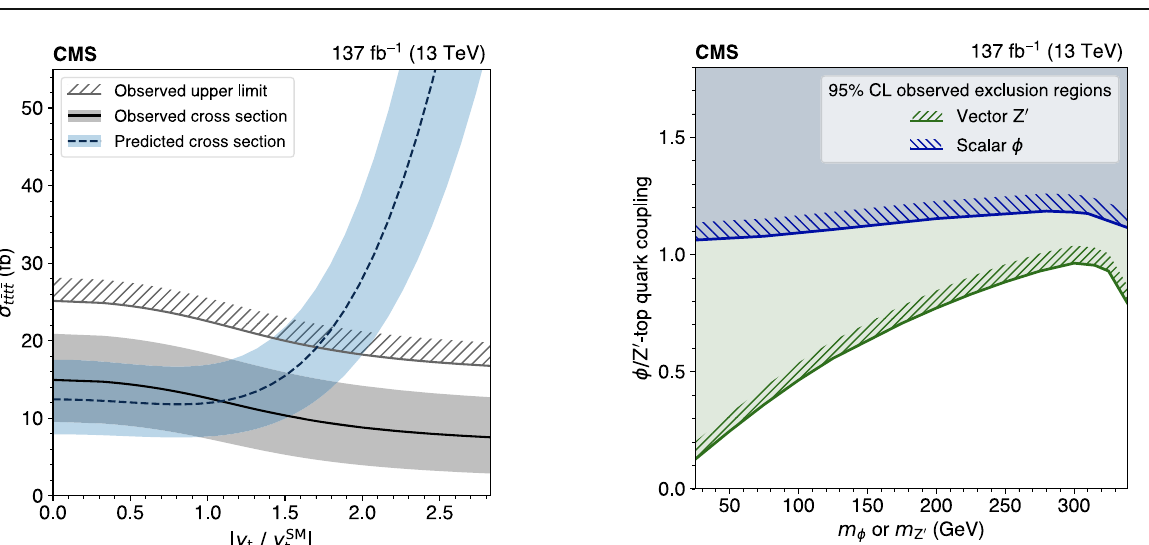
Fig. 5 The observed σ( pp → tttt) (solid line) and 95% CL upper limit (hatched line) are shown as a function of | y t / y SM t | . The predicted value (dashed line) [2], calculated at LO and scaled to the calculation from Ref. [1], is also plotted. The shaded band around the measured value gives the total uncertainty, while the shaded band around the predicted curve shows the theoretical uncertainty associated with the renormalization and factorization scales